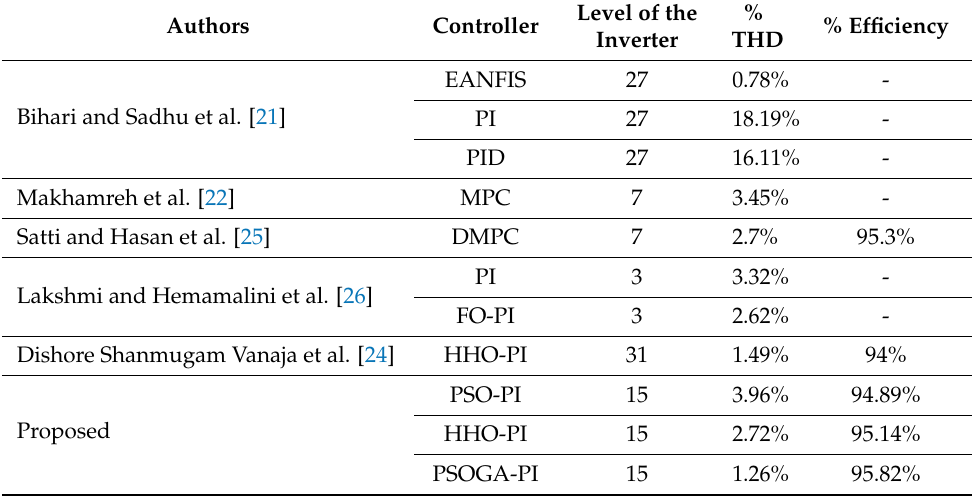
Table 8. Comparative analysis with other techniques proposed in the literature.